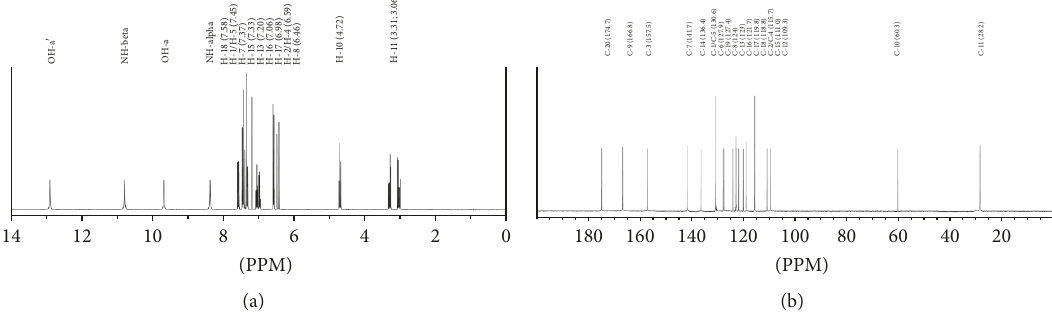
Figure 3: Proton and carbon NMR spectra for javamide-I. (a) Proton NMR spectrum and (b) carbon NMR spectrum. The proton and carbon numbers were depicted with chemical shifts in parenthesis.